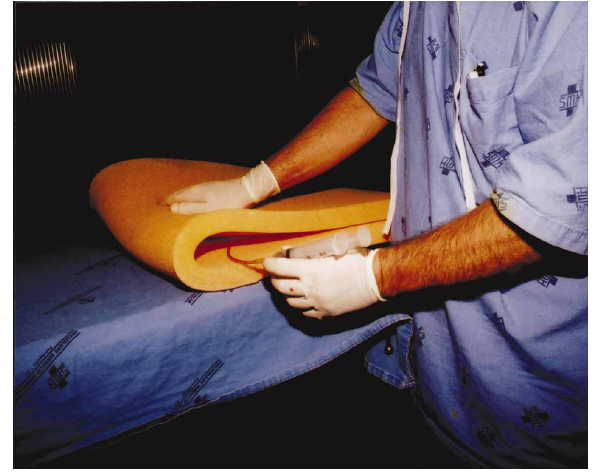
Figure 2 - With the kidney fixed, the foam is folded over it, and then, closed with scotch tape.